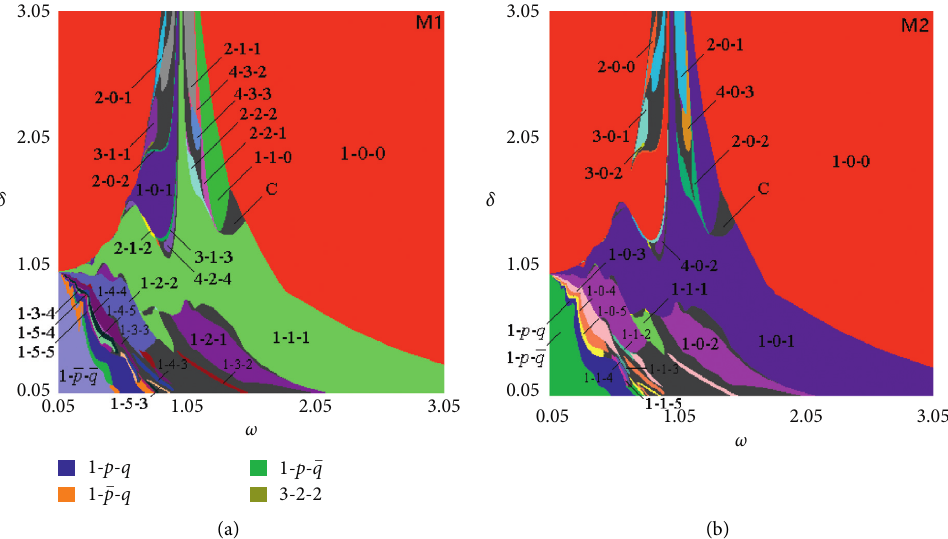
Figure 2: Under reference parameter conditions, the system presents dynamic characteristics in the ( ω , δ ) -parameter plane (a) mass M mass M 2